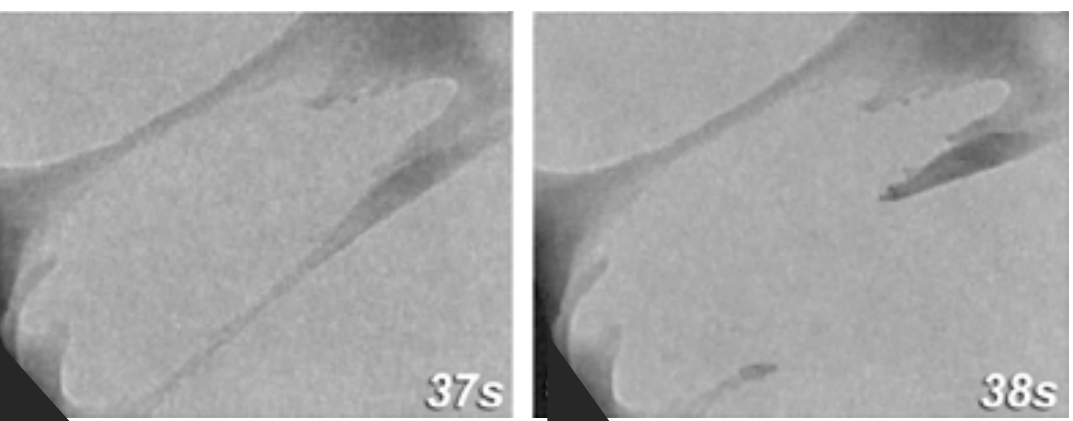
Figure 2. TEM still image sequence showing in situ deformation of organic matrix between plates with the time intervals shown in seconds. Adhesion at the wall is strong and failure will occur by deformation of the ligament. The recoiling broken strand shows densification at its base. Reproduced from [8] with permission from Cambridge University Press.